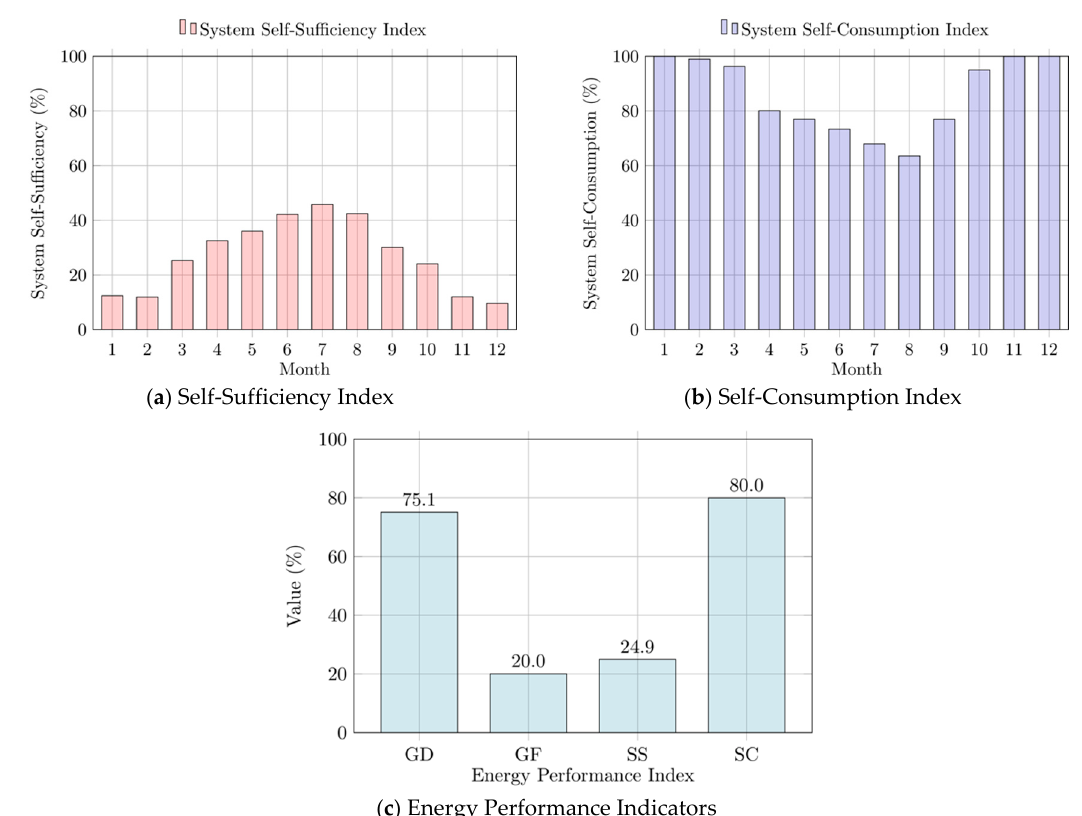
Figure 6. Energy key performance indicators (KPIs) of the system, based on data measured during 2017. In sub-figures ( a ) and ( b ) the self-sufficiency and the self-consumption of the system are reported for each month, respectively. In sub-figure ( c ), the grid-dependency (GD), grid-feed (GF), self-sufficiency (SS), and self-consumption (SC) indices are reported for the year 2017.